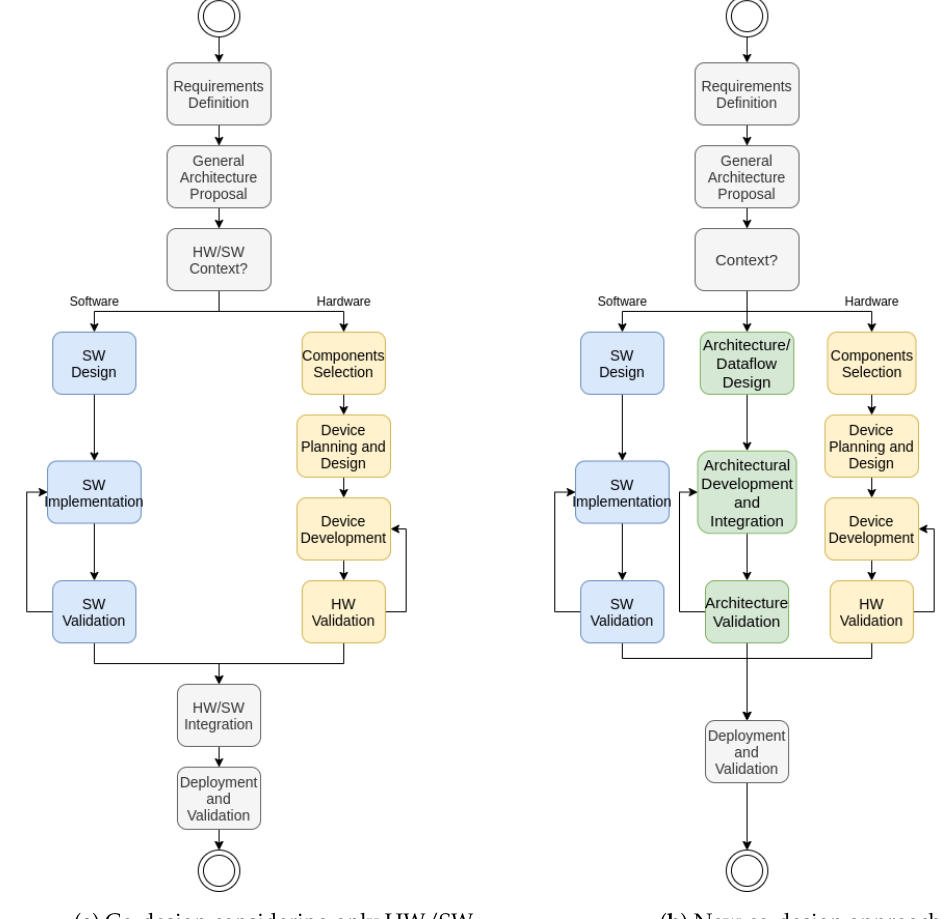
Figure 3. Co-design principle diagrams. The traditional approach does not consider architectural aspects in parallel with the HW and SW